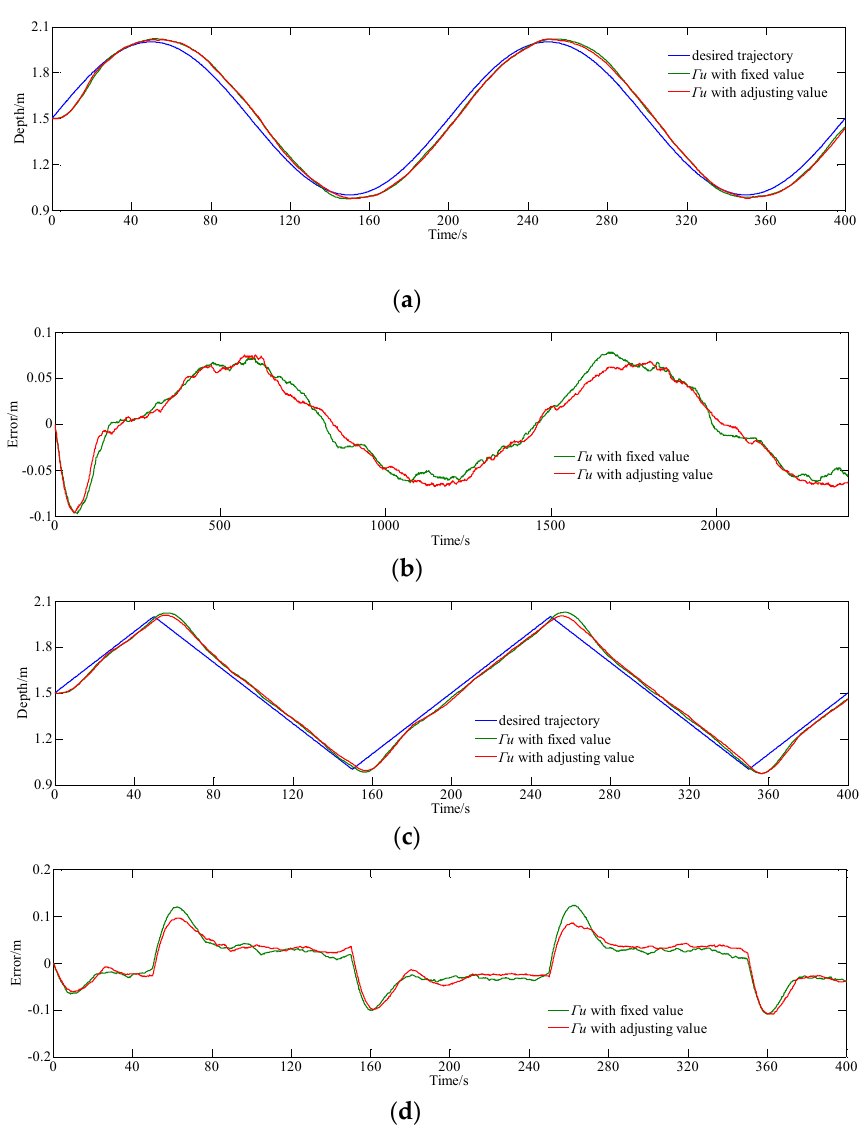
Figure 9. Contrast experiment result for MPC with fixed Γ u and adjusting Γ u tracking sinusoidal and triangular trajectories. ( a ) Depth data tracking sinusoidal trajectory; ( b ) error data tracking sinusoidal trajectory; ( c ) depth data tracking triangular trajectory; and, ( d ) error data tracking triangular trajectory. Table 2. Statistical Result of Figure 9.